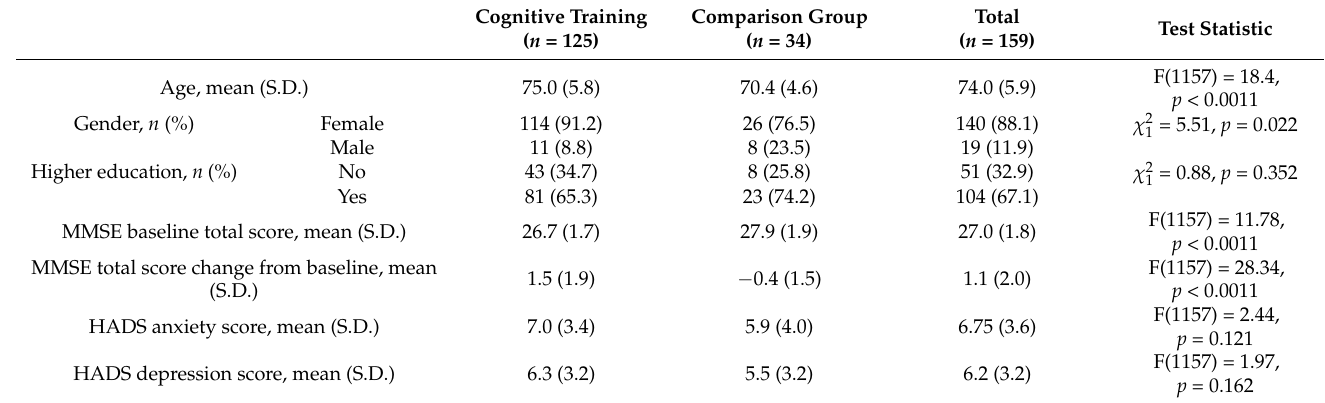
Table 1. General characteristics of study population. Higher education—5 years of education in university.